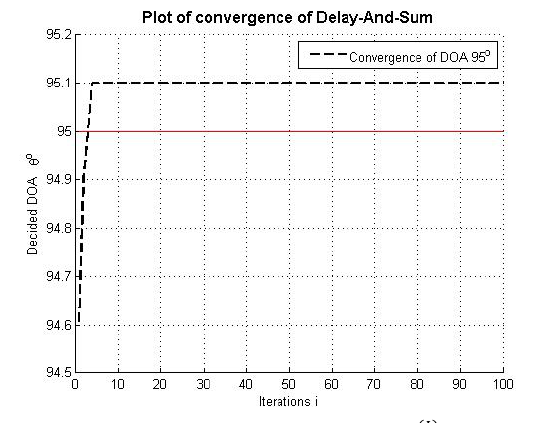
Figure 17: Convergence of decided DOA